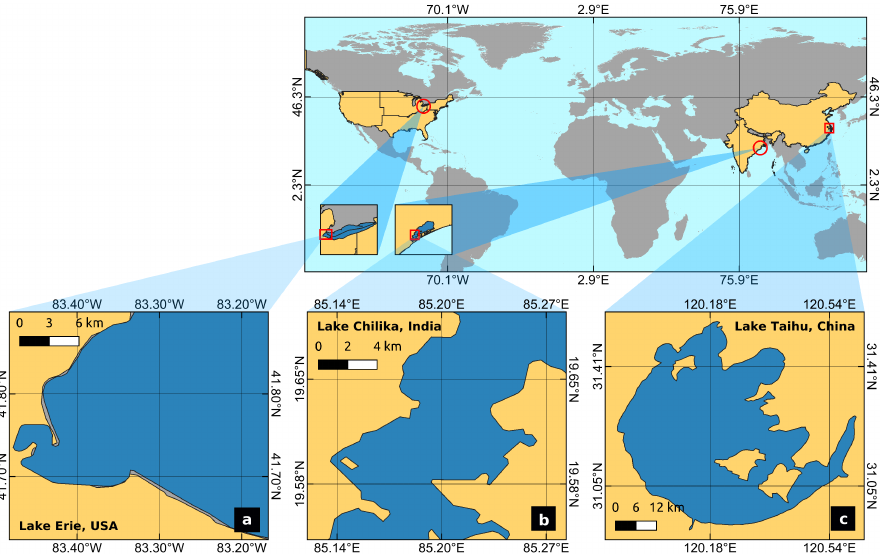
Figure 5. Spatial locations of the study